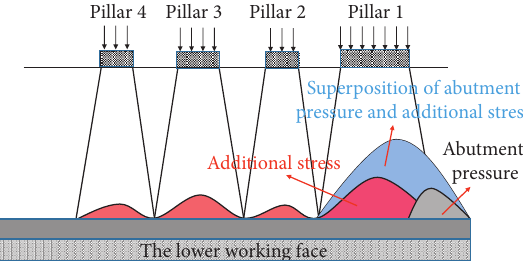
Figure 7: The superposition of additional stress and abutment